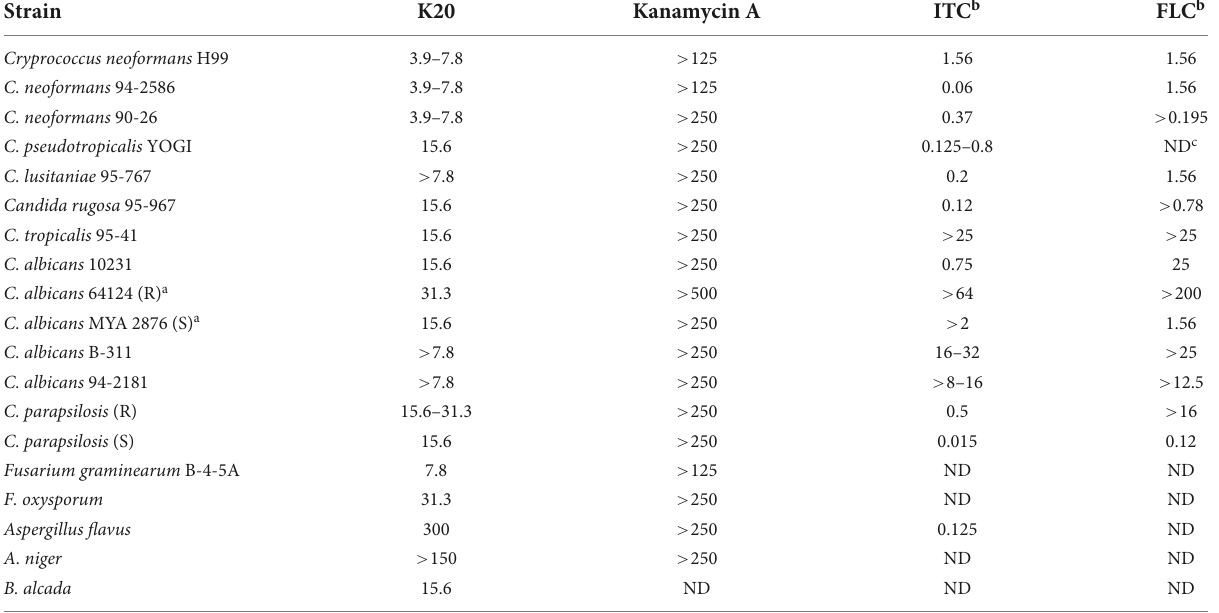
TABLE 4 MICs ( µ g/mL) of K20 and kanamycin A against bacteria and fungi a .